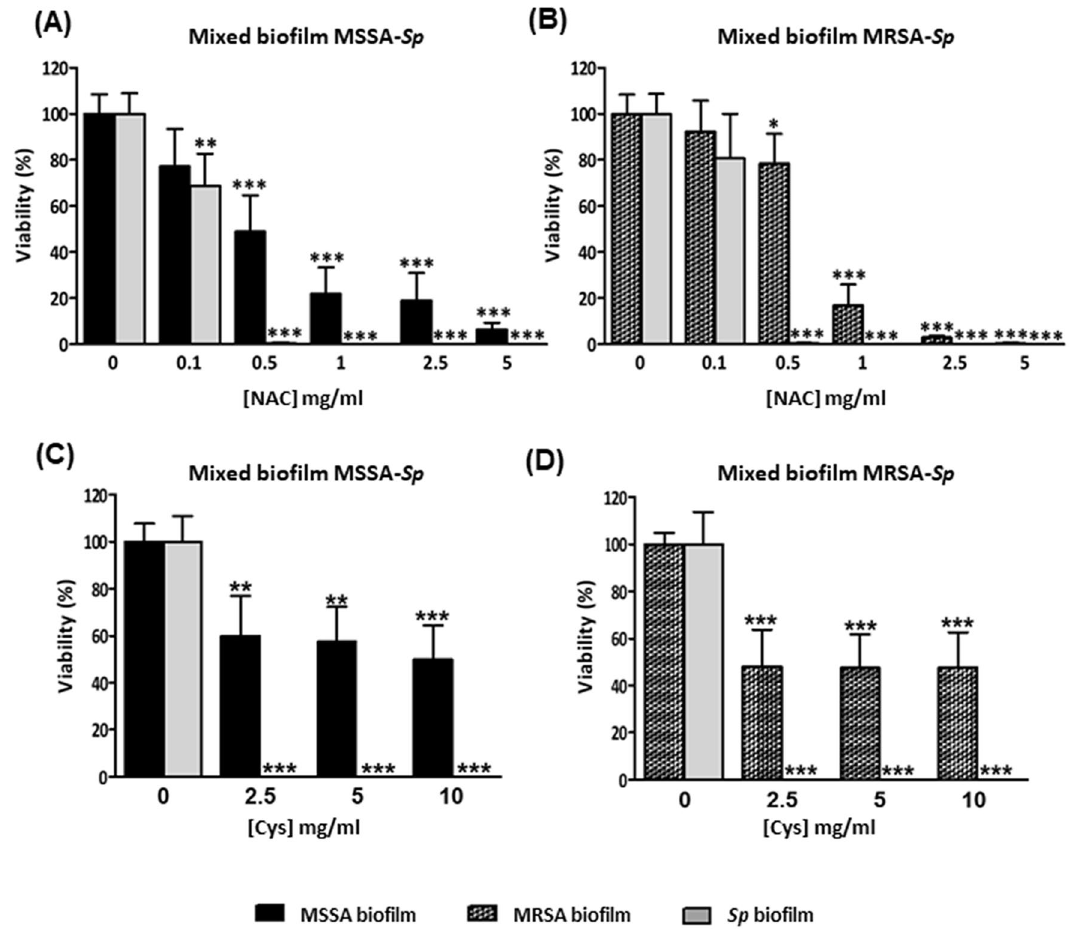
Figure 5. Treatment with antioxidants of MSSA/MRSA- Sp mixed biofilms (Disaggregation of mixed biofilms). Mixed biofilms were first incubated for 4 h at 34 °C, then washed with sterile H 2 Od and incubated with different concentrations of NAC ( A , B ) or Cys ( C , D ) for 1 h at 37 °C. The MIC of NAC for the S. pneumoniae strain was 2.5 mg/ml and 5 mg/ml for both MSSA /MRSA strains whereas the MIC of Cys for the S. pneumoniae strain and both S. aureus strains was 0.156 mg/ml. ( A , C ) Viability of MSSA- Sp mixed biofilm. ( B , D ) Viability of MRSA- Sp mixed biofilm. Black bars correspond to MSSA, grey bars correspond to S. pneumoniae , and grey patterned bars represent MRSA viable cells within the mixed biofilms. Data represent the average of at least three experiments. Standard deviation bars are shown, and asterisks mark statistically significant results (two-tailed Student’s t test: * P < 0.05; ** P < 0.01; *** P < 0.001) when comparing the treatment versus the non-treated biofilm. For multiple comparisons, we performed one-way ANOVA followed by a Dunnett’s post hoc test obtaining *** P < 0.001 in all the